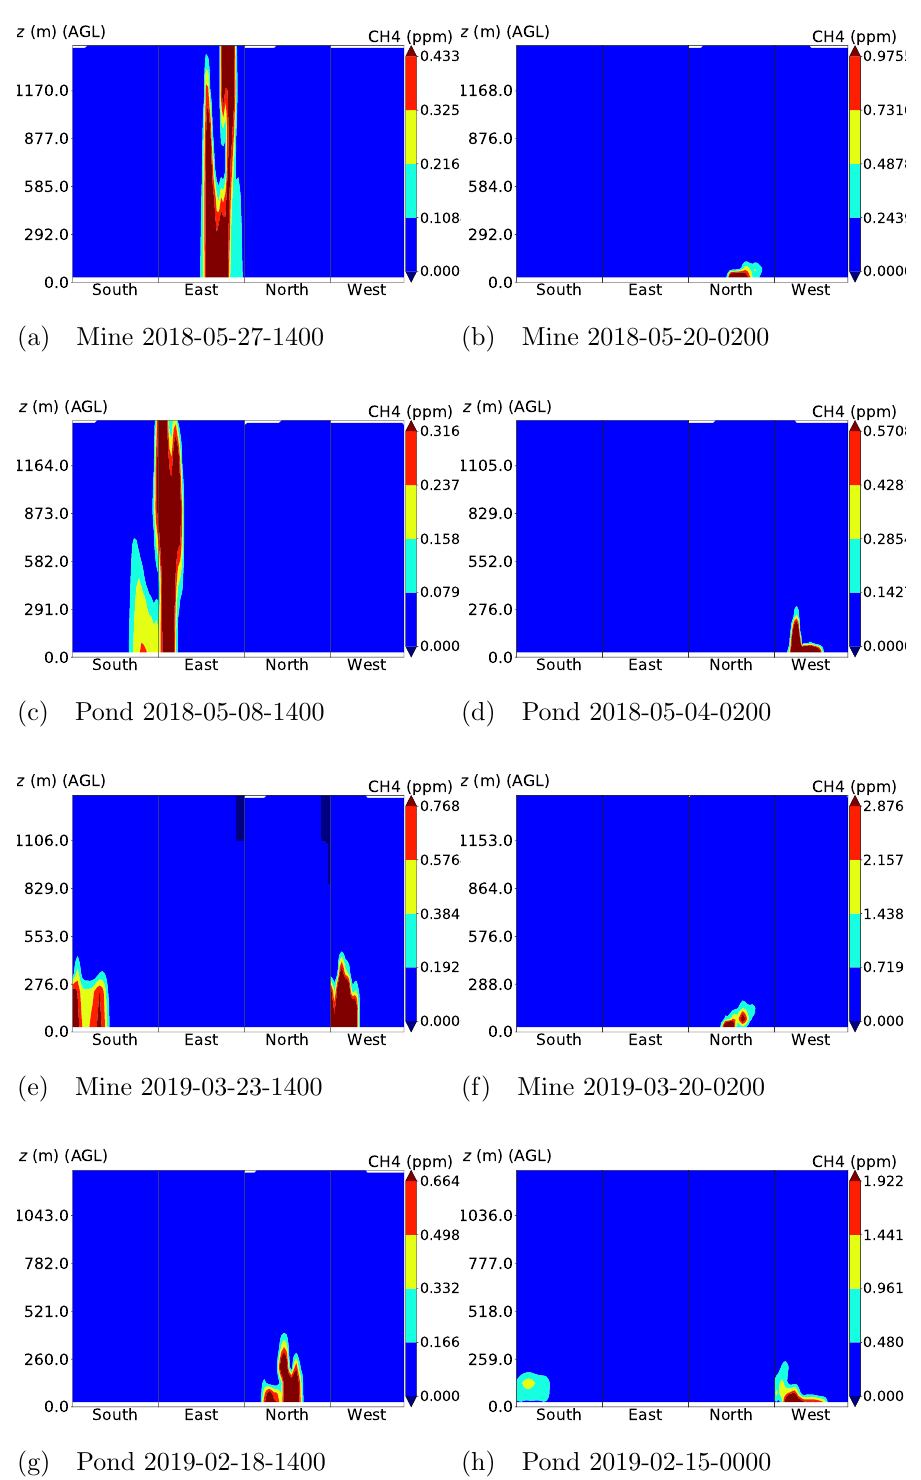
Figure 7. Vertical cross-section of the simulated methane mixing ratio at the south, east, north and west boundaries of domain 05; times in local standard time (LST = UTC − 7); ( a ) Mine 2018-05-27-1400; ( b ) Mine 2018-05-20-0200; ( c ) Pond 2018-05-08-1400; ( d ) Pond 2018-05-04-0200; ( e ) Mine 2019-03-23-1400; ( f ) Mine 2019-03-20-0200; ( g ) Pond 2019-02-18-1400; ( h ) Pond